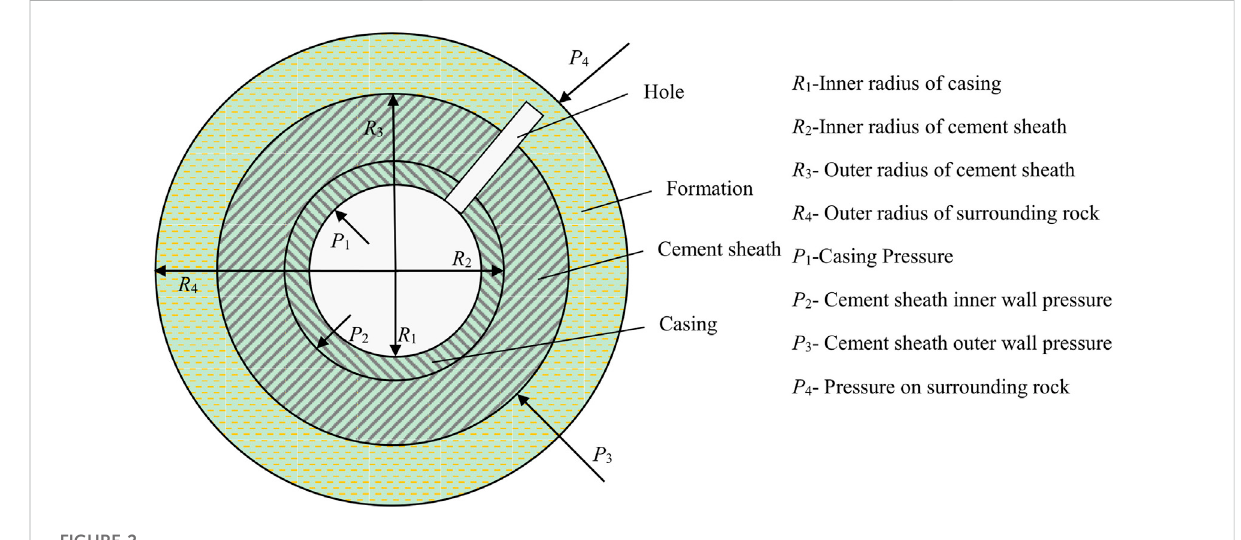
FIGURE 2 Schematic diagram of PCS mechanical model.